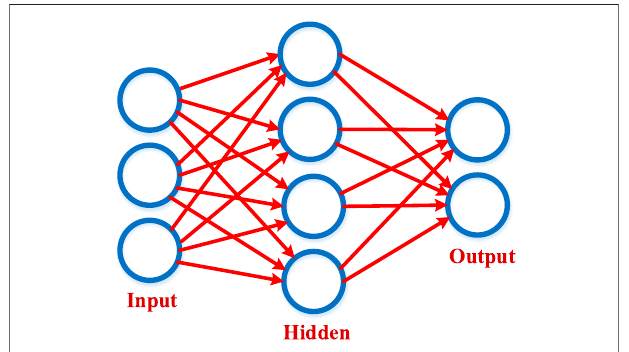
FIGURE 2 | Generic structure of the MLP.